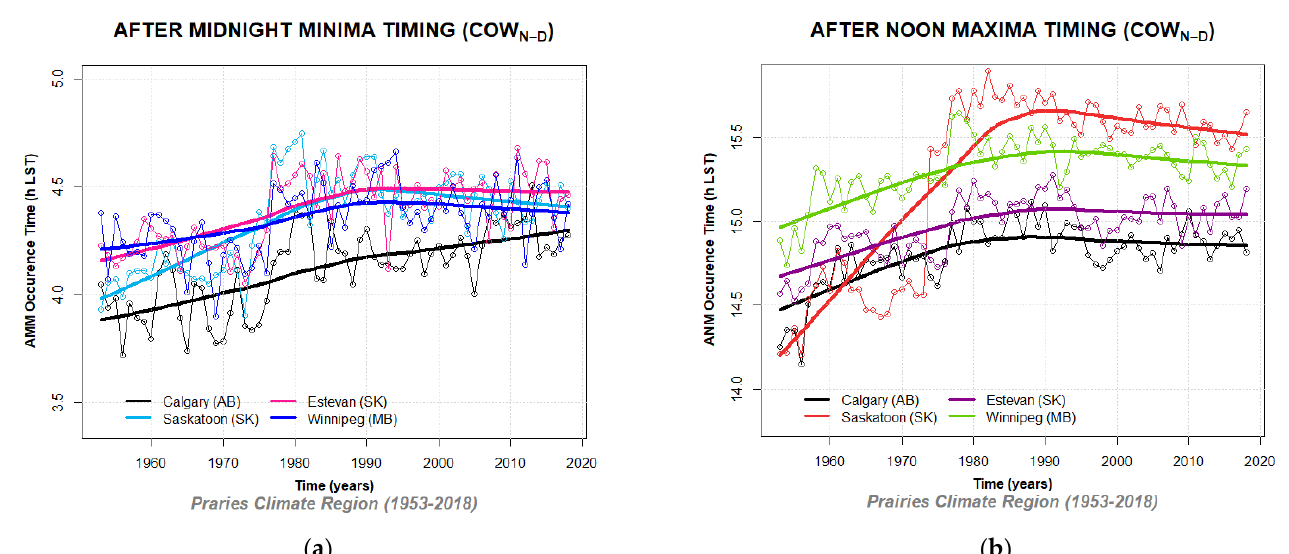
Figure A25. Annually averaged After Midnight Minima ( a ) and After Noon Maxima timing shifts ( b ) and LOESS fit curves for Calgary (AB), Saskatoon (SK), Estevan (SK), and Winnipeg (MB) temperature time series, Prairies climate region.